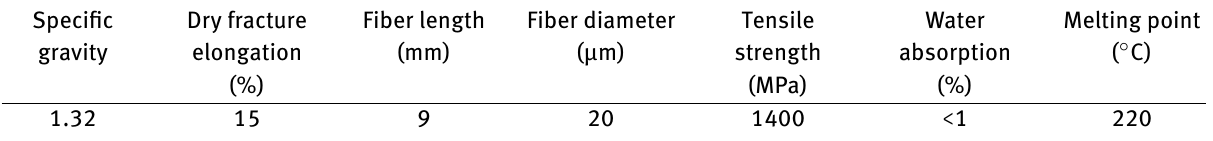
Fiber length (mm)